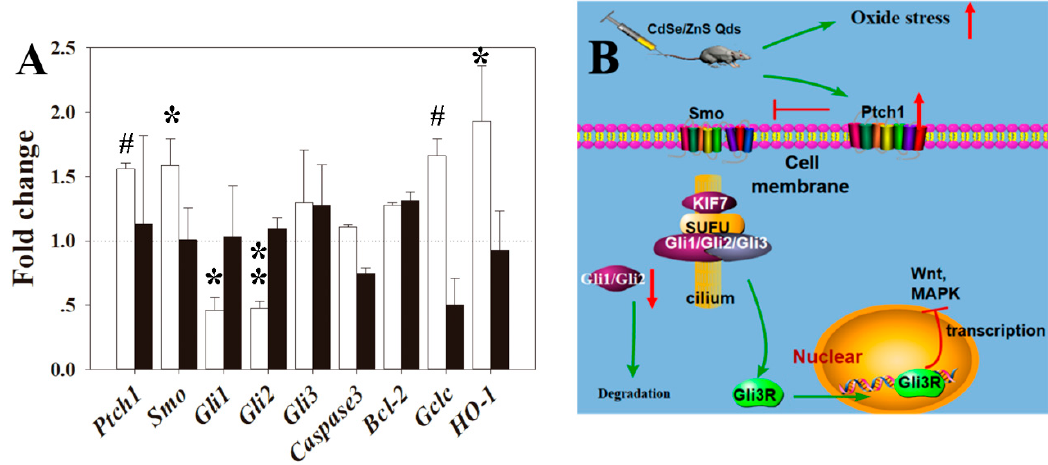
Figure 8. Gene expression and possible molecular mechanism after P0 exposure to QDs. ( A ) Fold changes of gene expression in P0 and F1 generations placentas. ( B ) Possible molecular mechanism. Relative gene expression levels were determined by the critical threshold (Ct) number and calculated using the 2 − ∆∆ C t method (fold change = 2 − ∆∆ C t value). Values were the mean ± standard deviation, n = 6. * p < 0.05, ** p < 0.01, # p < 0.001 vs. control.